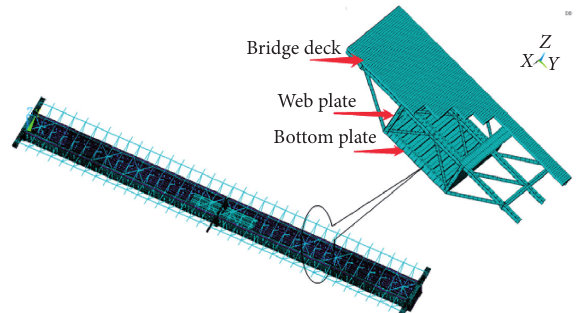
Figure 4: Finite-element model.